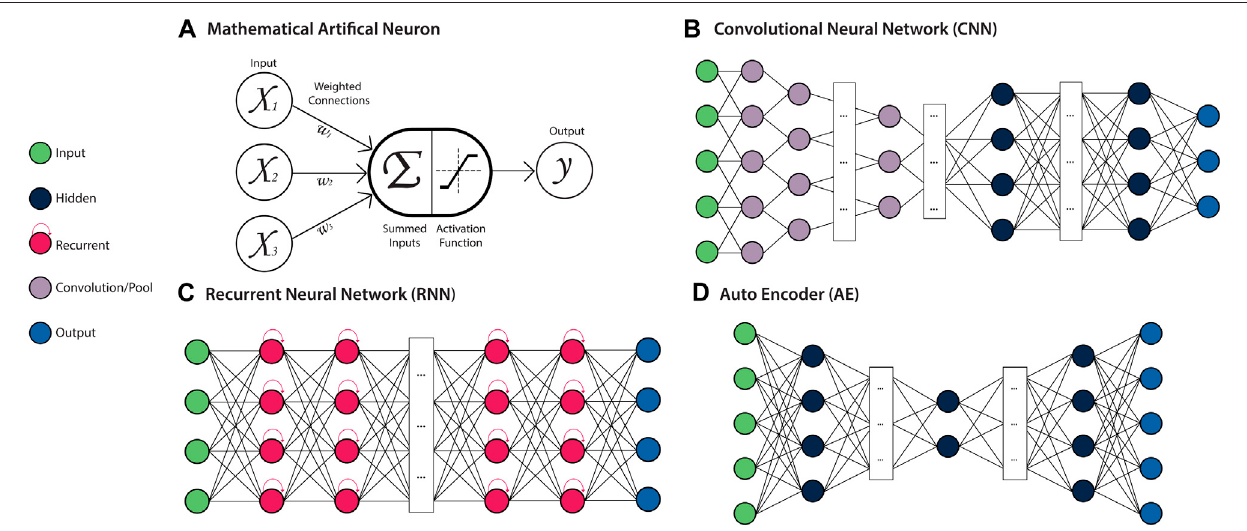
FIGURE 4 | Deep Arti fi cial Neural Network (ANN) Architectures. Left: a key for several types of neurons used in ANN architectures. (A) Mathematical model of a neuron. The weighted (Wi) sum of all inputs (Xi) to the neuron is computed and passed to the activation function, which produces the neurons output. This output is propagated as an input to neurons in subsequent layers of the network. (B) A Convolutional Neural Network (CNN) is a feed-forward ANN architecture containing convolutional and pooling layers, which allow local patterns to be learned and detected in a spatially invariant manner. (C) A Recurrent Neural Network (RNN) is a recursiveANNarchitecturecontainingneuronswithaninternalmemorystate,whichretaininformationaboutpriorinputstothemodel. (D) AnAutoencoder(AE)isafeed- forward ANN architecture that is comprised of an encoder module that learns a latent representation of the input, and a decoder module that reconstructs the original input data from the encoded